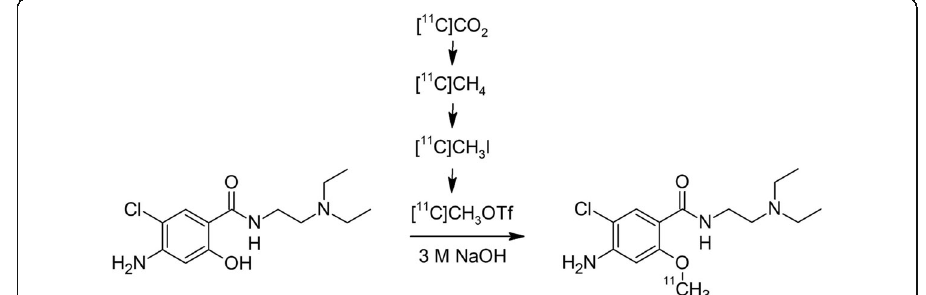
Fig. 1 Scheme for the radiosynthesis of [ 11